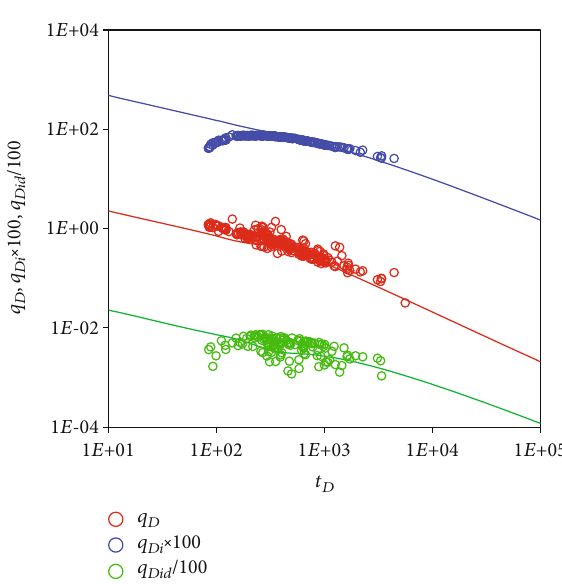
Figure 4: Type curve fi tting of the production data for well YY-1.